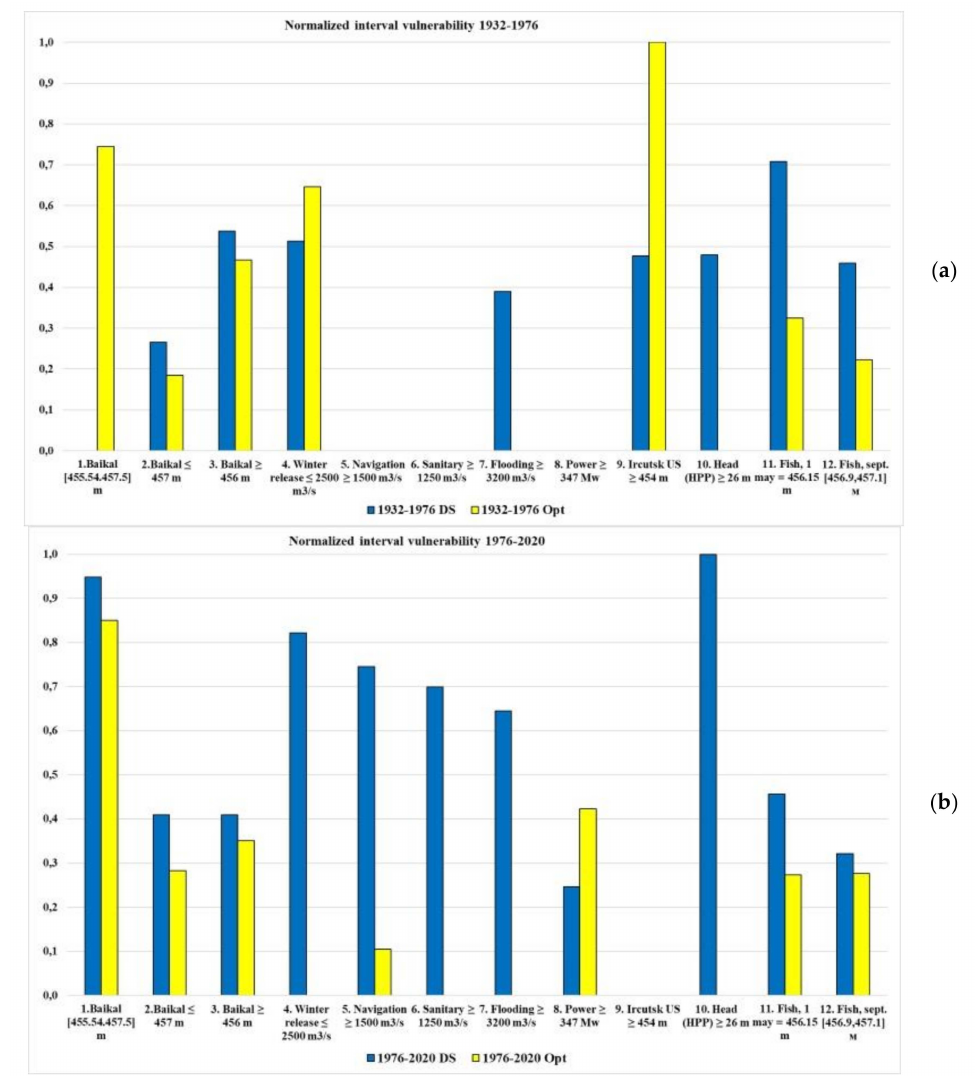
Figure 21. Interval vulnerability when WRC use DS and optimization ( a ) series 1932–1976 ( b ) series